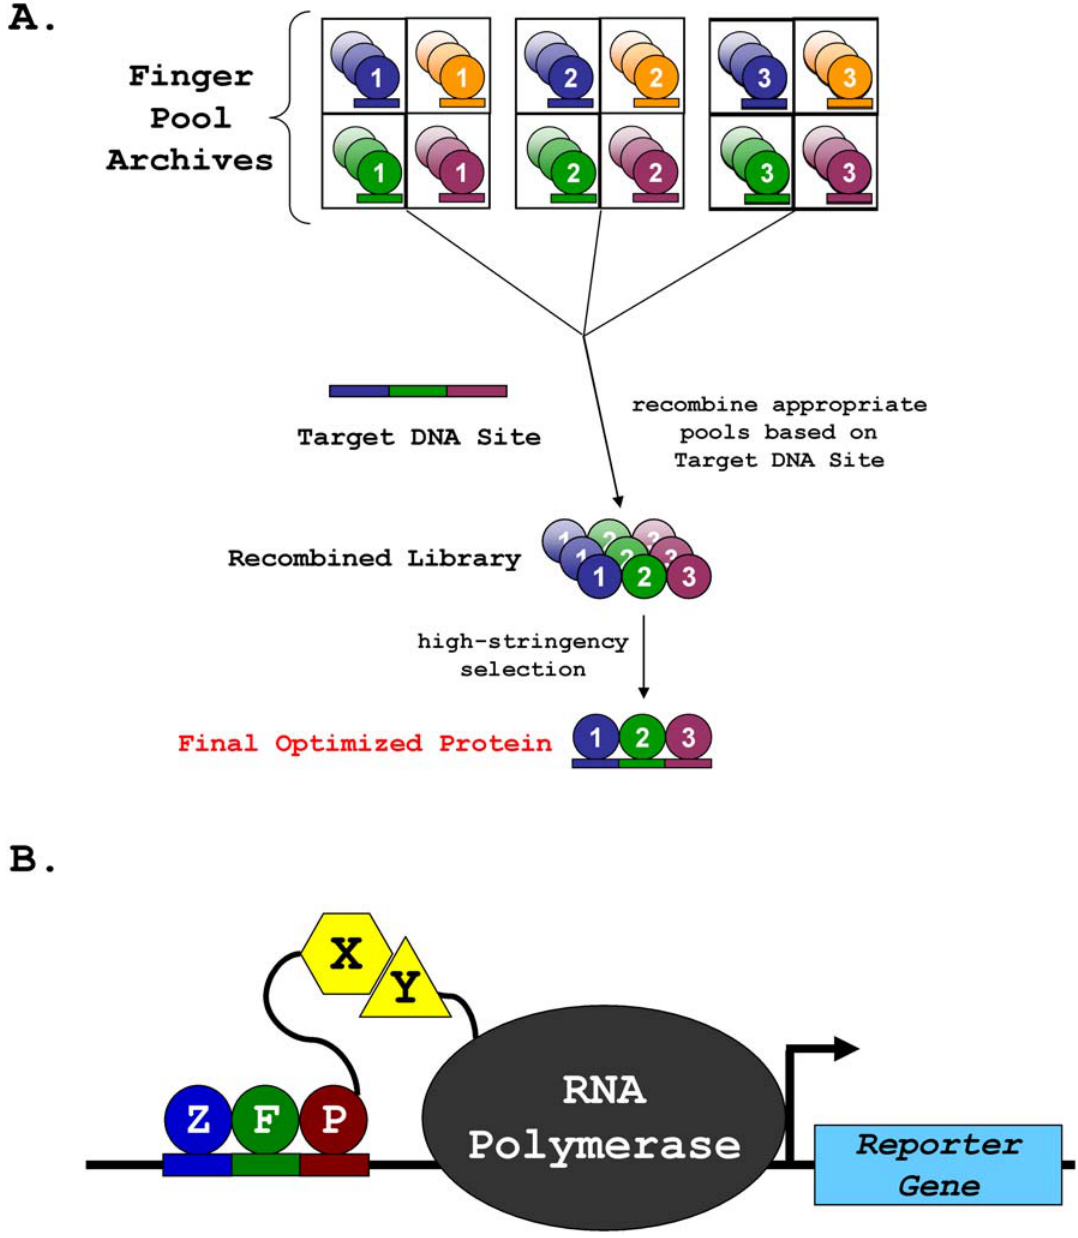
Figure 1. The OPEN Zinc Finger Selection Method. ( A ) Schematic overview of OPEN selection for a target DNA site. Zinc finger domains are shown as spheres and associated 3 bp subsites as rectangles. Details provided in the text and in Maeder et al., Mol. Cell 2008. ( B ) Schematic of the bacterial two-hybrid (B2H) system. ZFP=zinc-finger protein. X and Y=arbitrary interacting proteins. doi:10.1371/journal.pone.0004348.g001 finger arrays. We transcribed RNA from each of these 12 ZFN expression plasmids and performed poly A-tailing of the RNA as described in Materials and Methods.